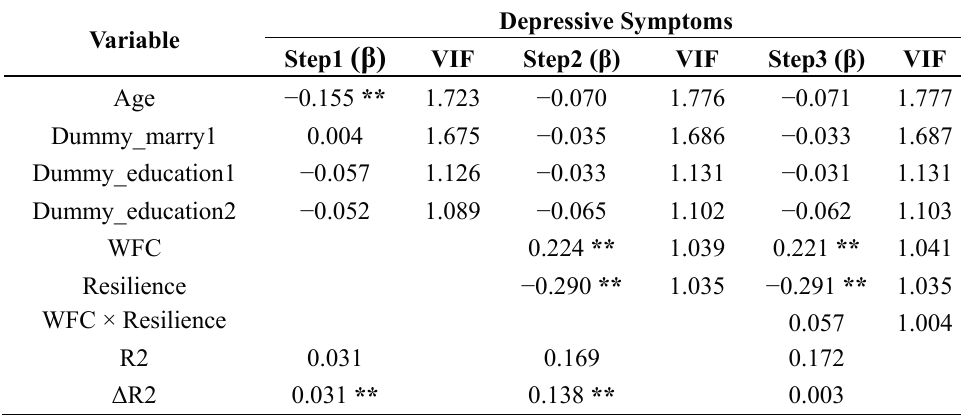
Table 7. WFC as the independent variable and resilience as the moderator in the regression analysis.